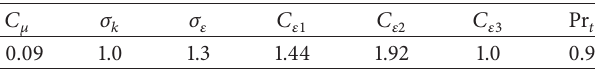
Table 4: Coefficients of the high Reynolds number 𝑘 - 𝜀